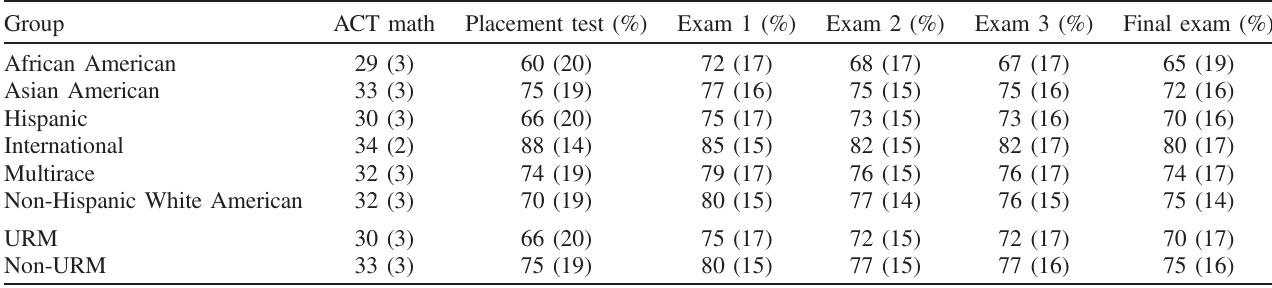
TABLE VI. Mean test scores by group. ACT Math scores are reported as raw scores, whereas the remaining exam scores are reported as percentages. Standard deviations are included in